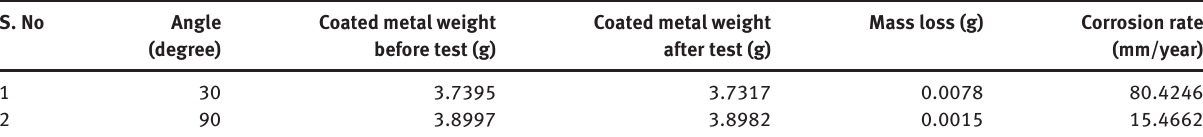
Table 3: Erosion and corrosion rate of coating material, friction surfaced deposit (extruded NAB alloy). S. No